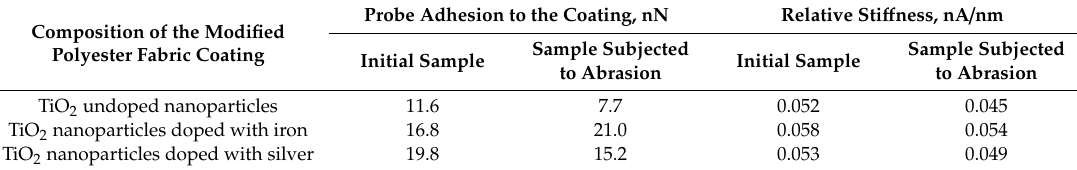
Table 2. Adhesion properties and sti ff ness of coatings formed on a polyester fabric.